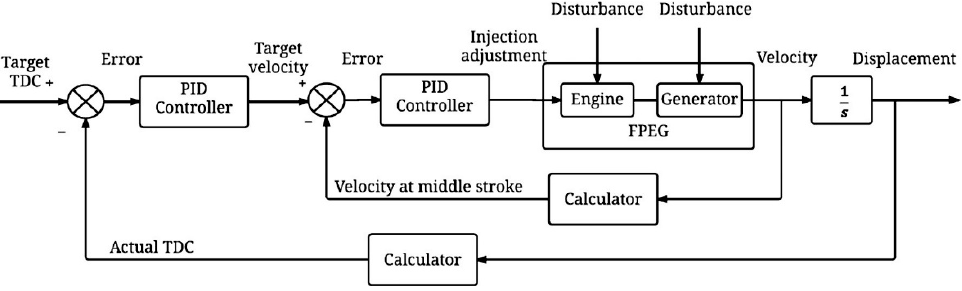
Figure 23. Block diagram FPLG coupled with cascade control [51].